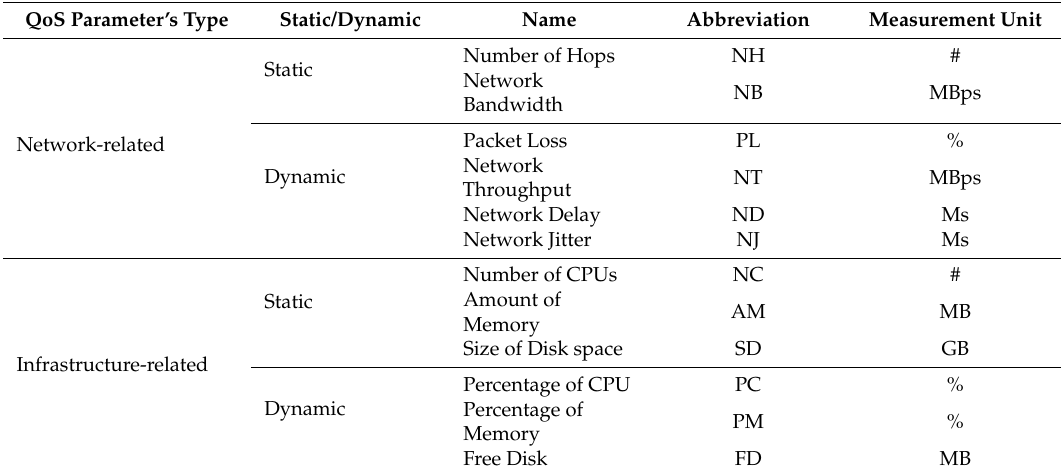
Table 2. List of QoS parameters for autonomic